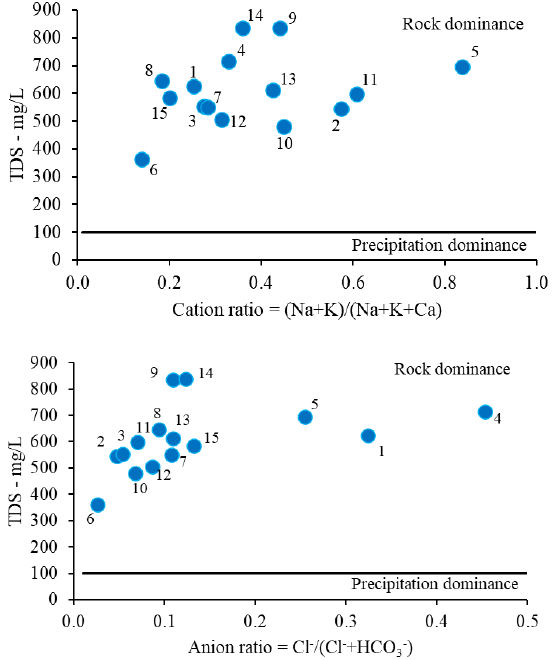
Figure 5. Gibbs plots applied for water samples 1-15. The typology of waters was classified using the Piper diagram. Based on the major cations and anions, the Piper plot indicates the water types. The majority of samples are included in the CaMgHCO 3− typology. Samples 4 and 5 are classified into the mixed ty- pology. The mixed typology of those two samples is correlated to the highest amounts of nitrogen compounds, SO 42− , Cl − , HCO 3− , and also the highest values for the EC, TDS and t H . Based on the cations trilinear plot, samples were generally included in the calcium type, except samples 2 and 11, which were not characterized by any dominant type. On the other side, the trilinear anions plot groups two water types, namely sulphate type (sam- ples 2, 3, 5–15) and non-dominant type (samples 1 and 4) (Figure 6). Ca 2+ CATIONS M g 2+ N a + + K + C O 32 - + H C O 3 - S O 42 - Cl - ANIONS S O 4 2 - + C l - C a 2+ + M g 2+ EXPLANATION 1 2 3 4 5 6 7 8 9 10 11 12 13 14 15